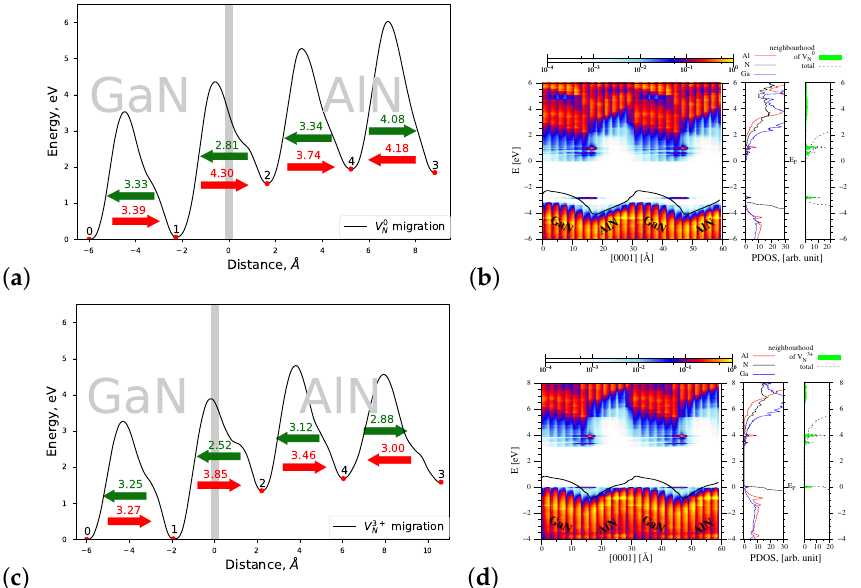
Figure 5. Left—joint profiles of the migration energy barriers of nitrogen vacancy V N at the AlN/GaN strained interface type, right—the density of states projected on the atom quantum states (PDOS), showing the spatial variation of the valence and conduction bands in the GaN/AlN heterostructure, as well as the total DOS and PDOS functions associated with Al, N, and Ga atoms, denoted by red, black, and blue lines, respectively. The green shade represents a sum of the PDOS resulting from the nearest neighbors of V N . ( a , b ) V 0 , the corresponding potential jump ∆ V = 0.97 eV ( c , d ) V 3 + , N N the corresponding potential jump ∆ V = 0.74